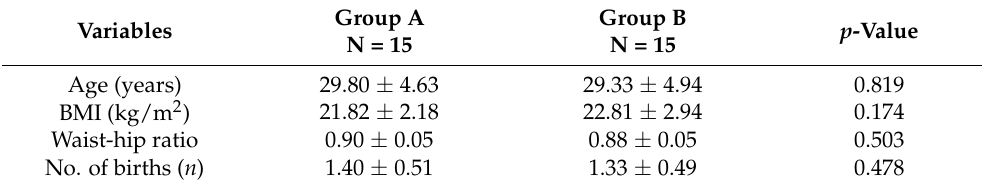
Table 1. Baseline demographics of participants, postpartum and asymptomatic, control (Group A), PSUI participants (Group